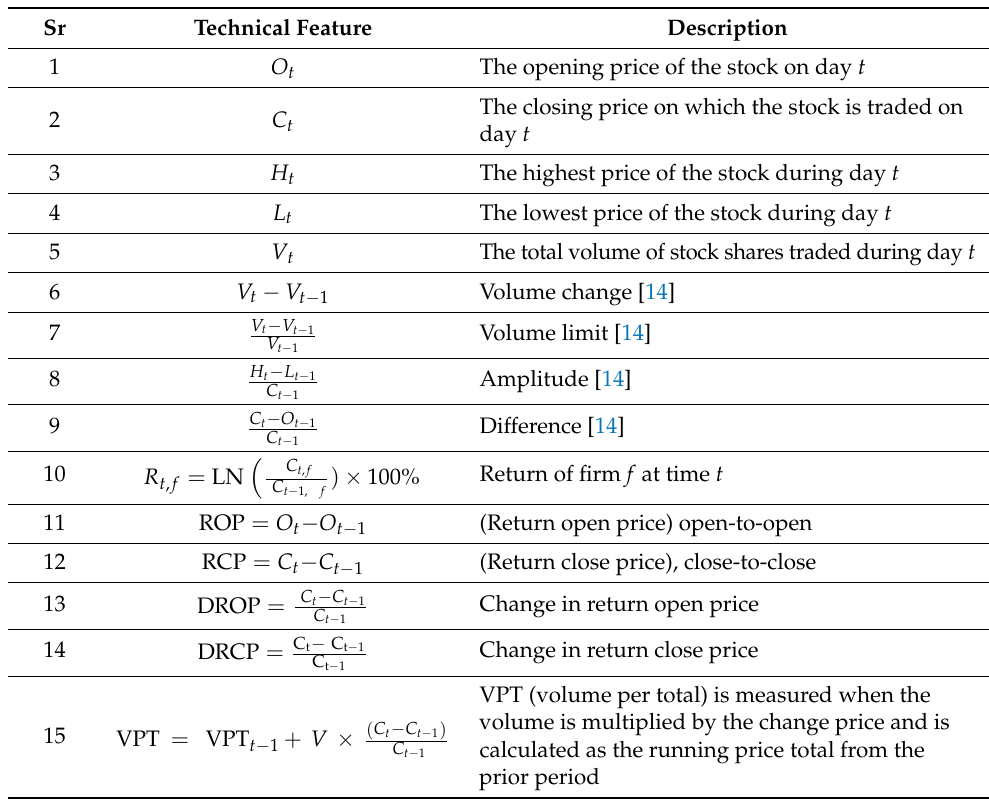
Table 1. Technical features with